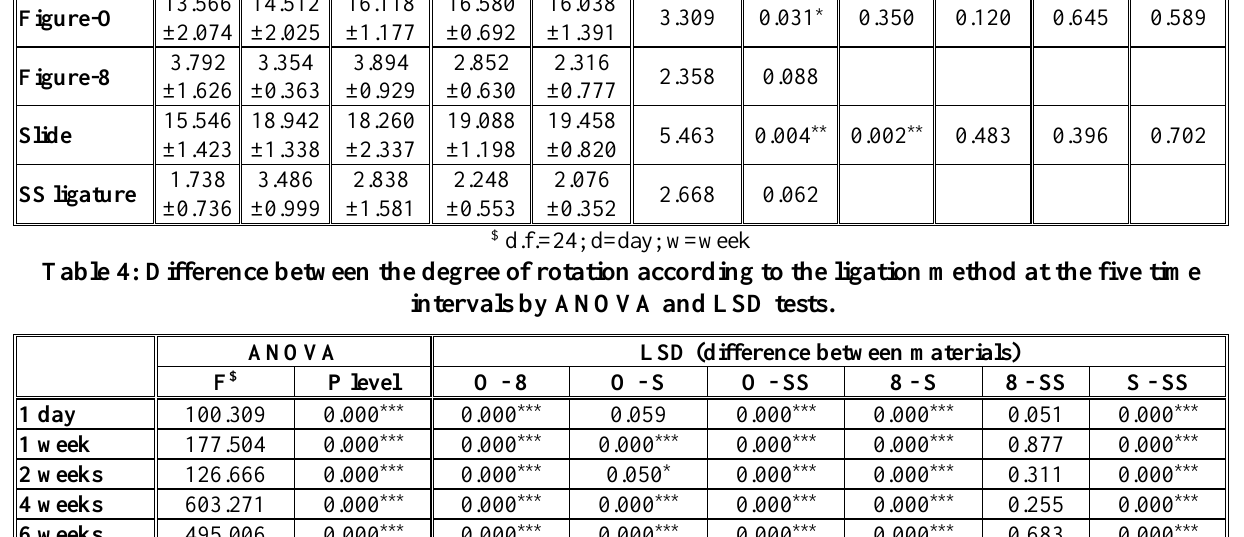
Table 3: Descriptive statistics (Mean ± S.D.) of the degree of rotation (in degrees) with ANOVA and LSD tests for the difference between the time intervals. Material